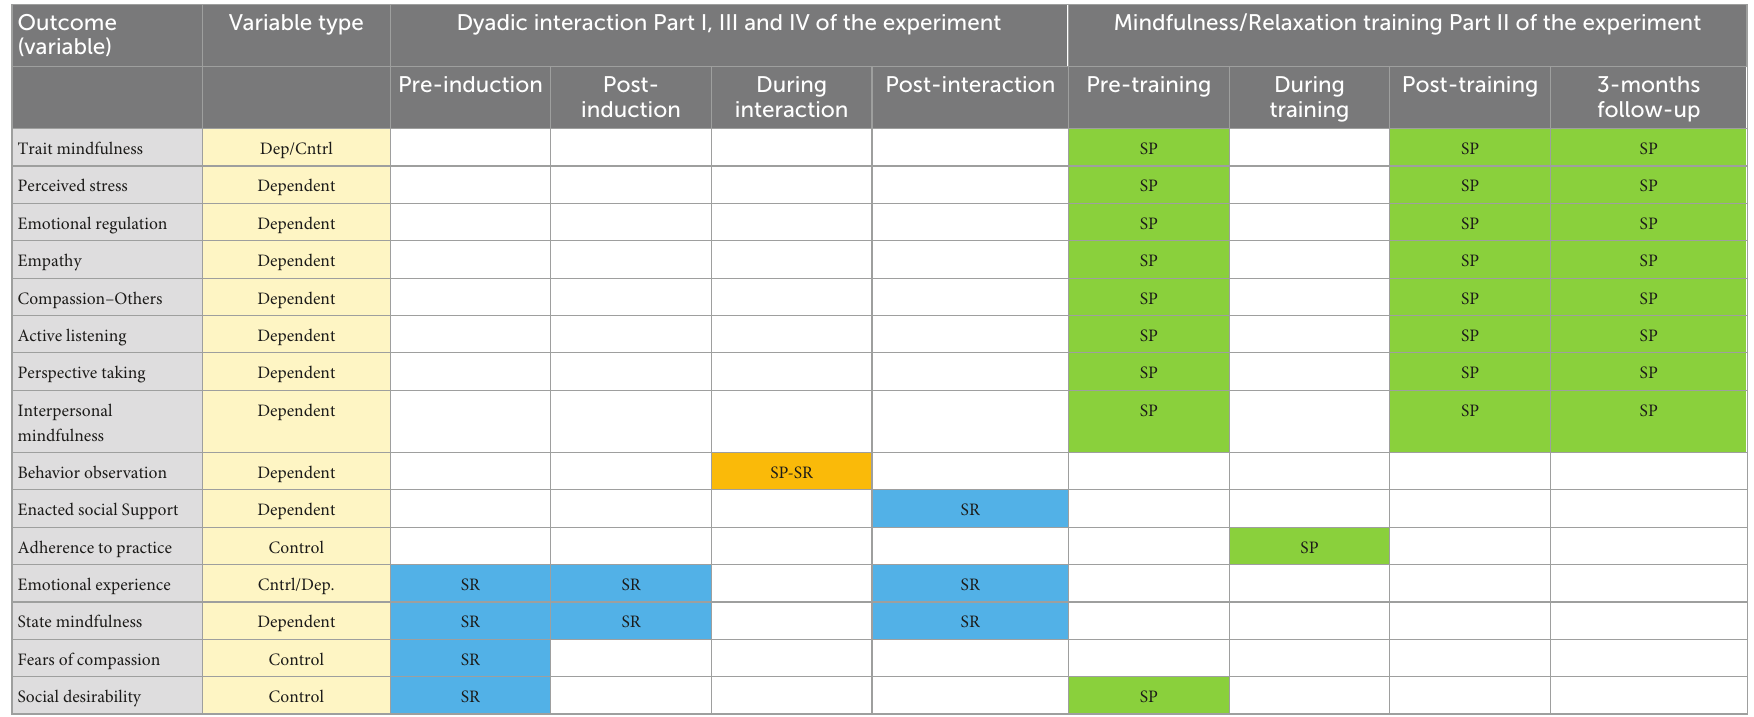
TABLE 1 Sequence of administering the measures during the